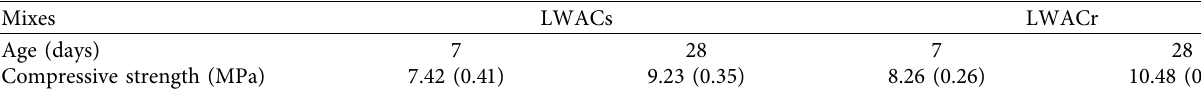
Figure 8: Roughness measurements: (a) optical microscopy image. (b, c) SEM images of LWACs mix. (d, e) SEM images of LWACr mix. Table 1: Compressive strength values at 7 and 28 days.